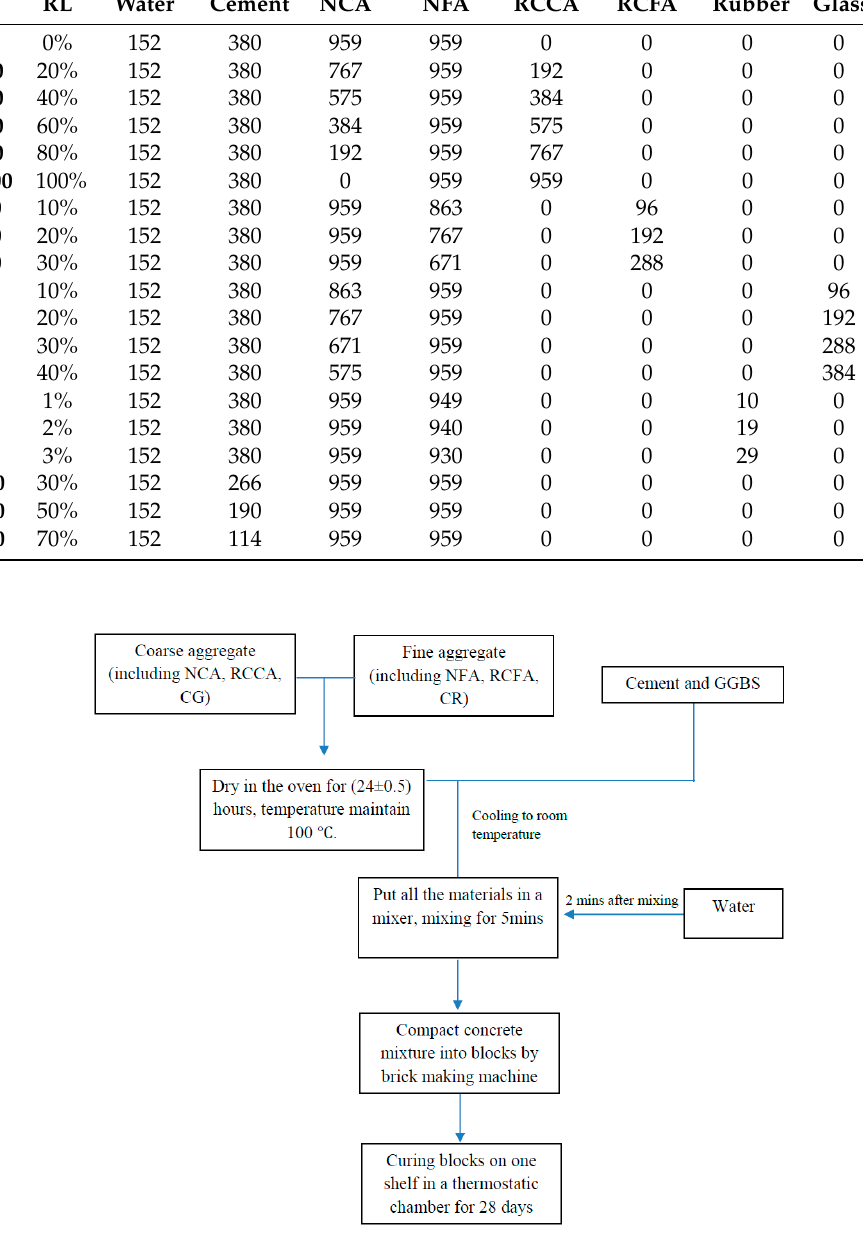
Figure 2. The process of manufacturing the concrete paving blocks.